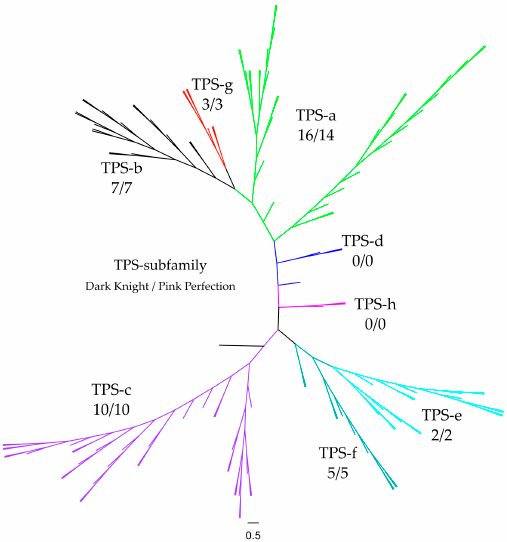
Figure 7. Phylogenetic tree of putative terpene synthases (TPS) within Caryopteris x clandonensis cultivars Dark Knight (DK) and Pink Perfection (PP). TPS-a (green), TPS-b (black), TPS-c (purple), TPS-d (blue), TPS-e (turquoise), TPS-f (petrol), TPS-g (red), TPS-h (pink). For phylogenetic tree construction, TPS a-h of selected plant species were included to assure correct classification of identified TPS. Numbers below the respective TPS subfamily indicate the count of predicted TPS in the genomes of the